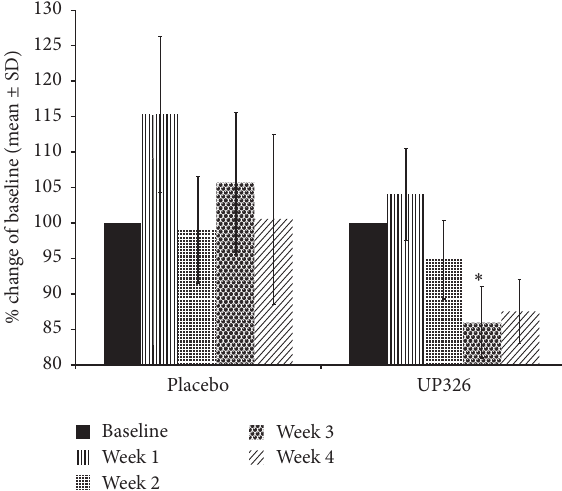
Figure 5: Working memory speed and reaction time standard deviation showed improvement from baseline to week 4. Relative to group A (placebo), a significant improvement in working memory processing efficiency seen for groups B (UP326) in week 3 of treatment ( ∗ 𝑝 < 0.05